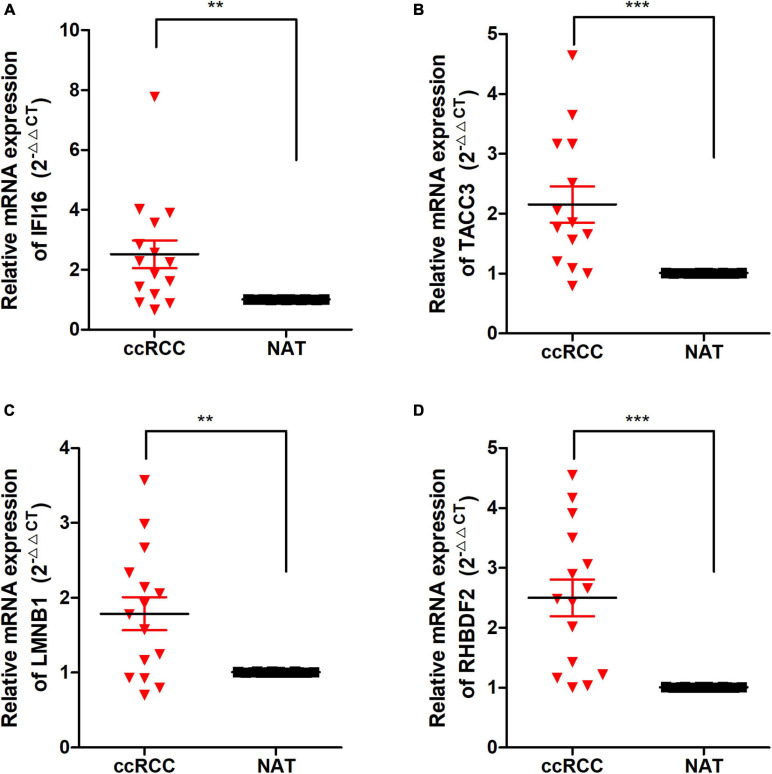
The expression of these Hub genes in human ccRCC specimens and adjacent normal tissues (ANT). (A–D) q-RTPCR analysis of IFI16 (A), TACC3 (B), LMNB1 (C), and RHBDF2 (D) in paired ccRCC tissues (n = 15). GAPDH was used as a loading control. *p < 0.05, **p < 0.01, ***p < 0.001.